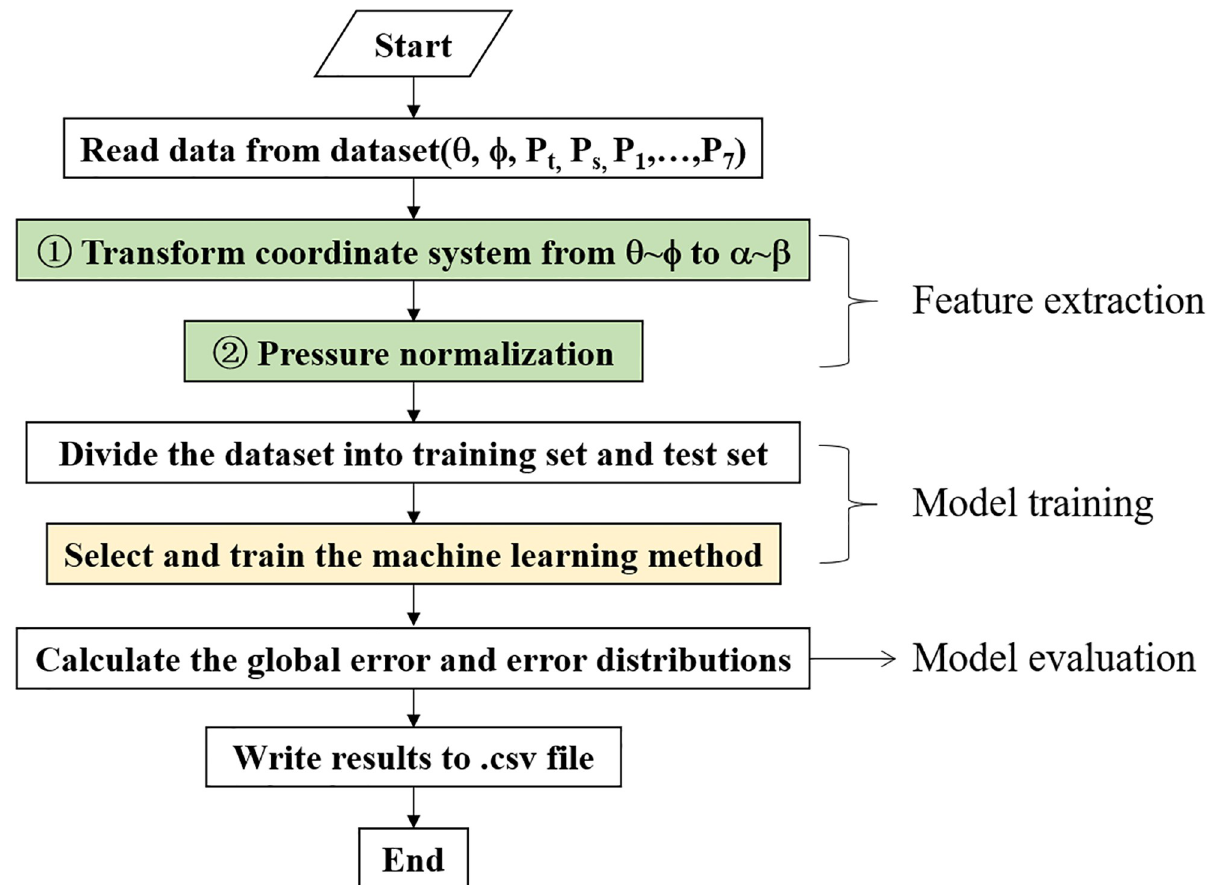
Fig 4. Basic flow chart of the seven-hole probe calibration with machine learning methods.